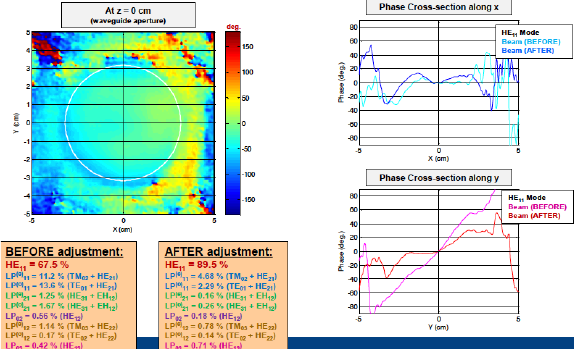
Fig. 6. The mode content and the phase front of the back- propagated beam at the waveguide mouth before adjustment and after adjustment.